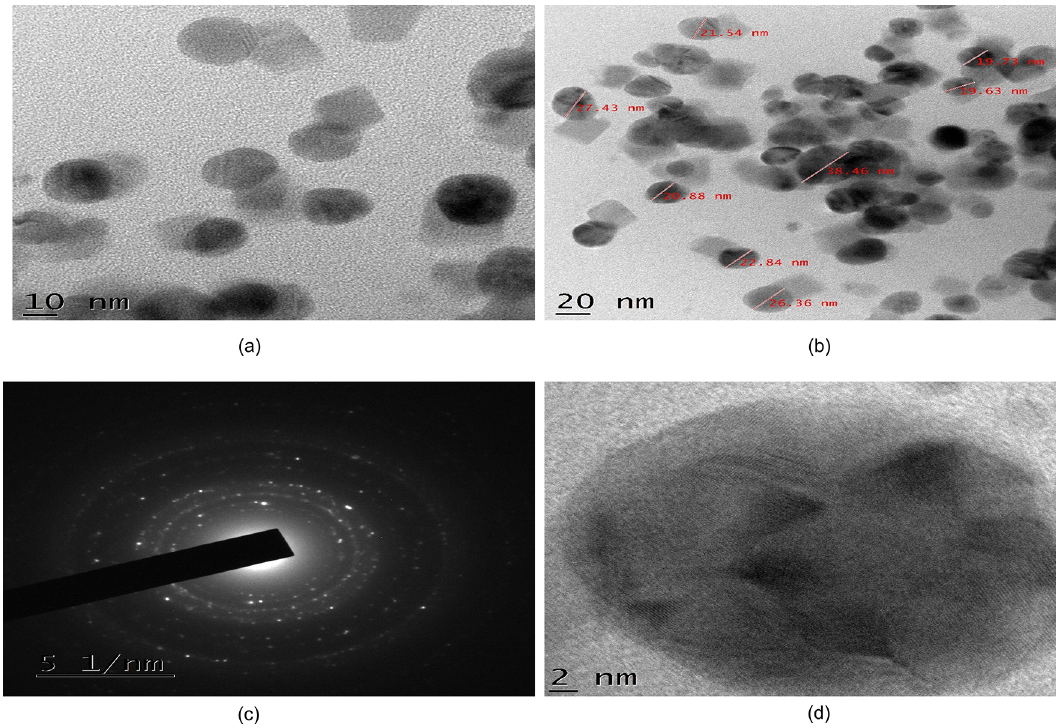
Figure 3. ( a ) TEM micrographs image of the synthesized AgNPs, ( b ) TEM image of different sized AgNPs, ( c ) SAED image of AgNPs, ( d ) HR-TEM image of AgNPs.